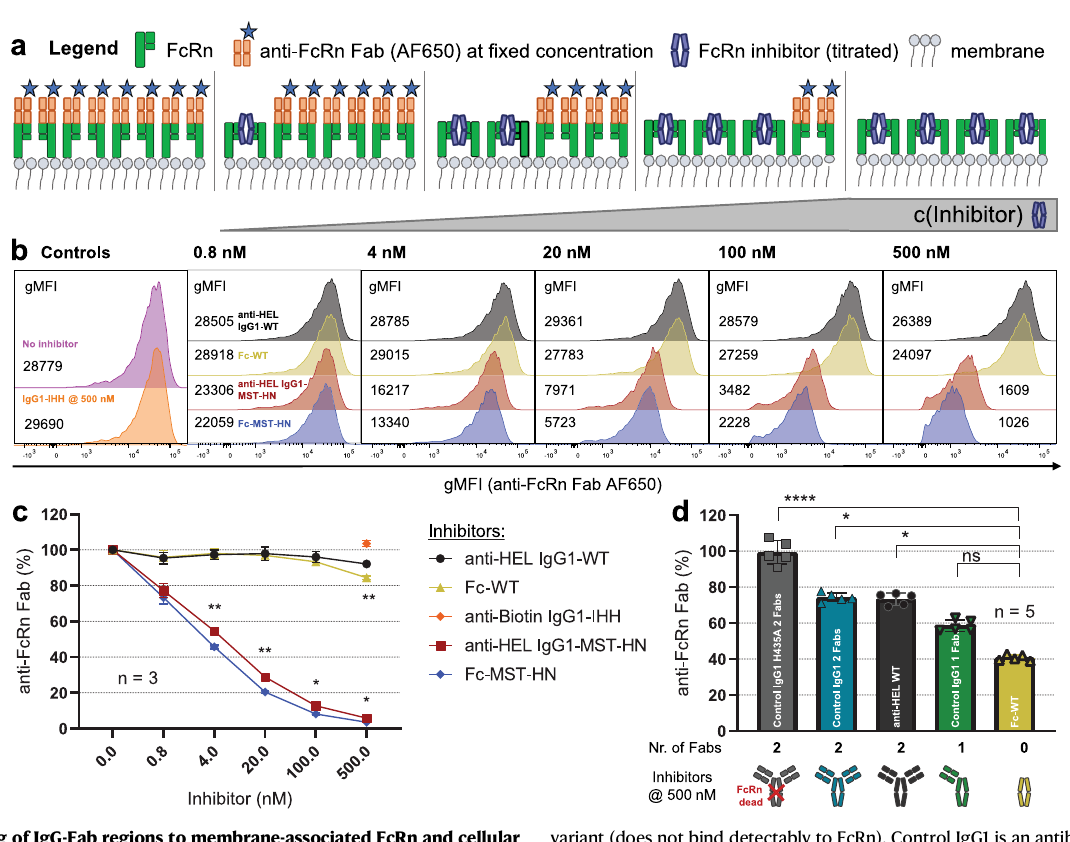
variant (does not bind detectably to FcRn). Control IgG1 is an antibody directed against anirrelevant and non-disclosed target. Detection (AF650-labeled anti-FcRn Fab):inhibitor molar ratio at highest inhibitor concentration=1:250 (optimized to measure competition with WT-IgG). Data represent histograms from a repre- sentative experiment, with indicated numbers showing gMFIs averaged from measured duplicates from the same experiment in ( b ), with aggregated data pre- sented as mean values from three independent experiments in ( c ) and fi ve in ( d ) using fl ow cytometry. Error bars indicate standard deviations. Statistical analysis was performed using a two-way ANOVA (Tukey ’ s multiple-comparisons test) ( c ) and one-way ANOVA (Dunn ’ s multiple-comparisons test) comparing to Fc-WT ( d ) and statistically signi fi cant differences are indicated by asterisks: *<0.05, **<0.01, ****<0.0001. ns not signi fi